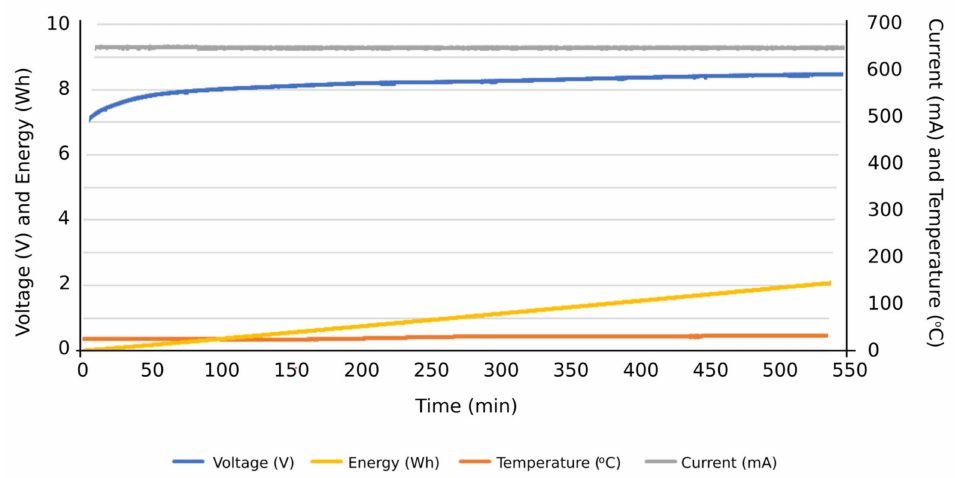
Figure 18. Results of a charging cycle at a constant intensity of 600 mA with a threshold voltage of 10 V.